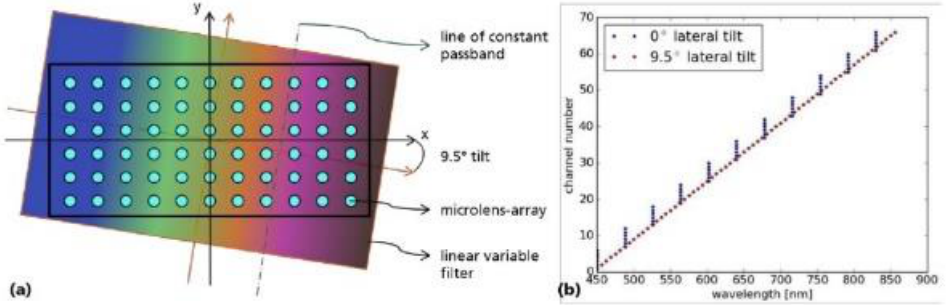
Figure 33. MTF diagrams for three different wavelengths (450, 665, and 880 nm) and two different field positions.